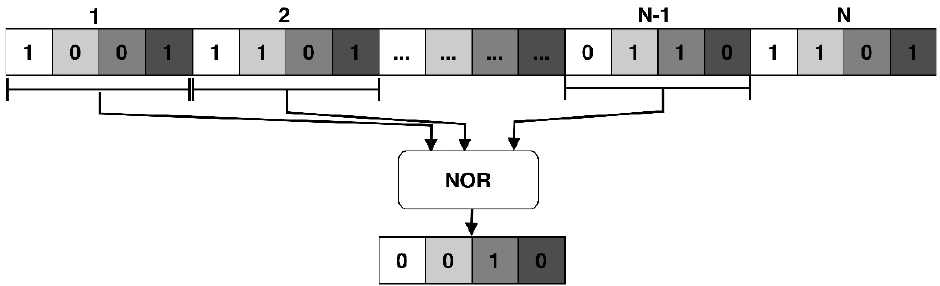
Figure 6. The check process of one thread in the evaluate check kernel.